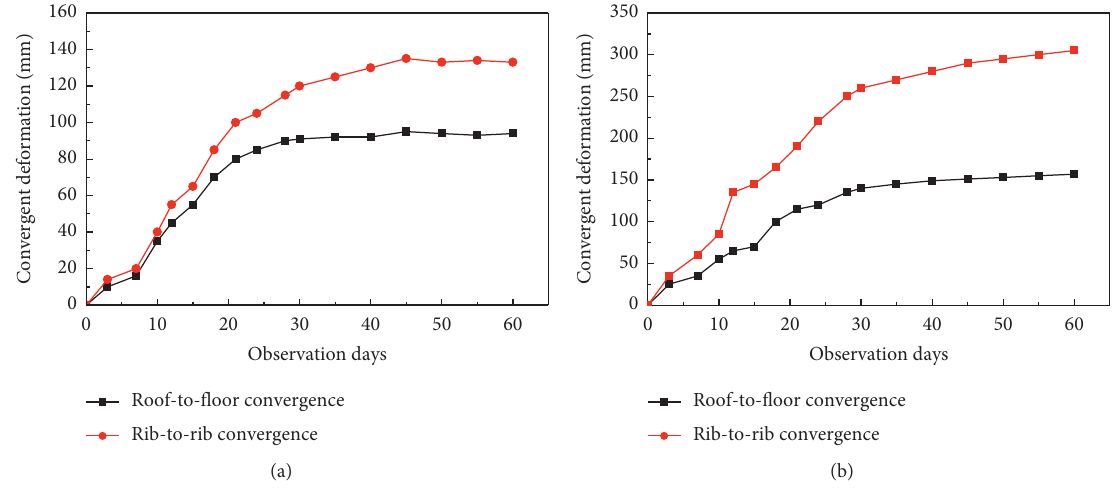
Figure 16: Convergence of surrounding rock of gas tailgate, (a) before and (b) after